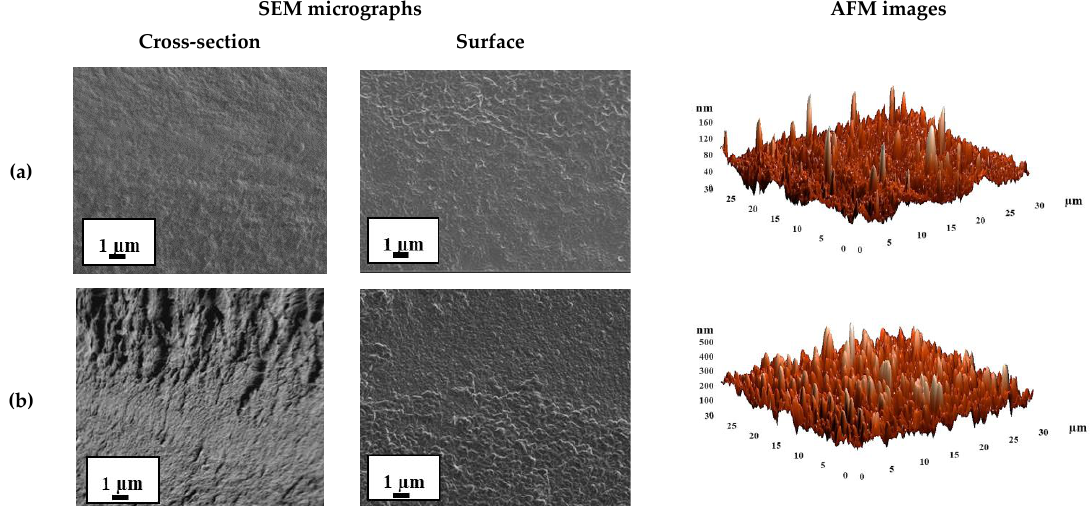
Figure 8. The cross-sectional and surface SEM micrographs and AFM images of cross-linked ( a ) SA-0 CaCl2 and ( b ) SA-5 CaCl2 membranes.